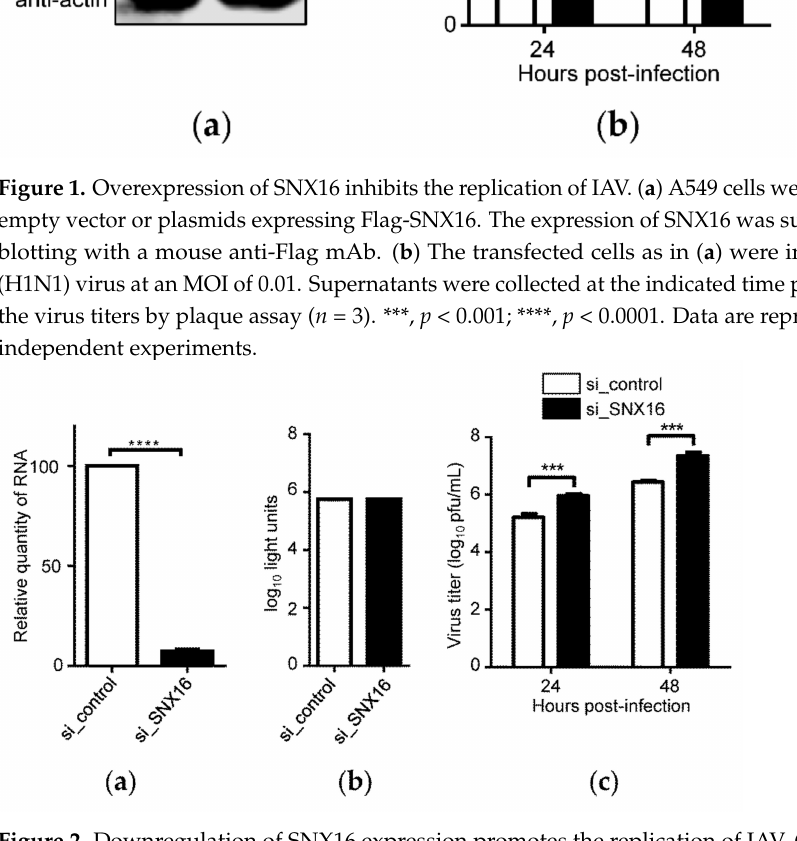
Figure 2. Downregulation of SNX16 expression promotes the replication of IAV. ( a ) A549 cells were transfected with siRNA targeting SNX16 or with scrambled siRNA for 48 h and the expression of SNX16 was detected by RT-qPCR ( n = 3), ****, p < 0.0001. ( b ) Viability of A549 cells treated with SNX16-specific or scrambled siRNA was determined by using a CellTiter-Glo assay ( n = 3). ( c ) A549 cells treated with siRNA for 48 h were infected with WSN (H1N1) virus (MOI = 0.01). Supernatants were collected at 24 and 48 h p.i., and virus titers were determined by plaque assays on MDCK cells ( n = 3). ***, p < 0.001. Data are representative of three independent